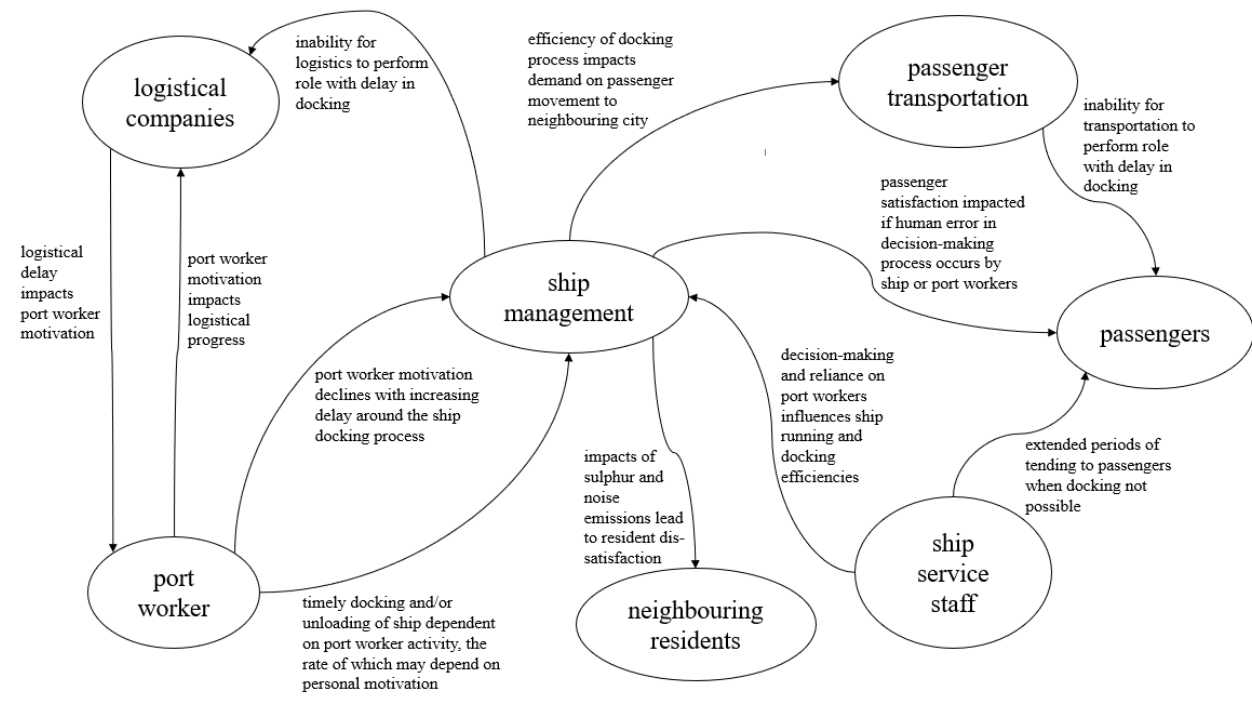
Figure 1. A Selection of Port Stakeholders and their